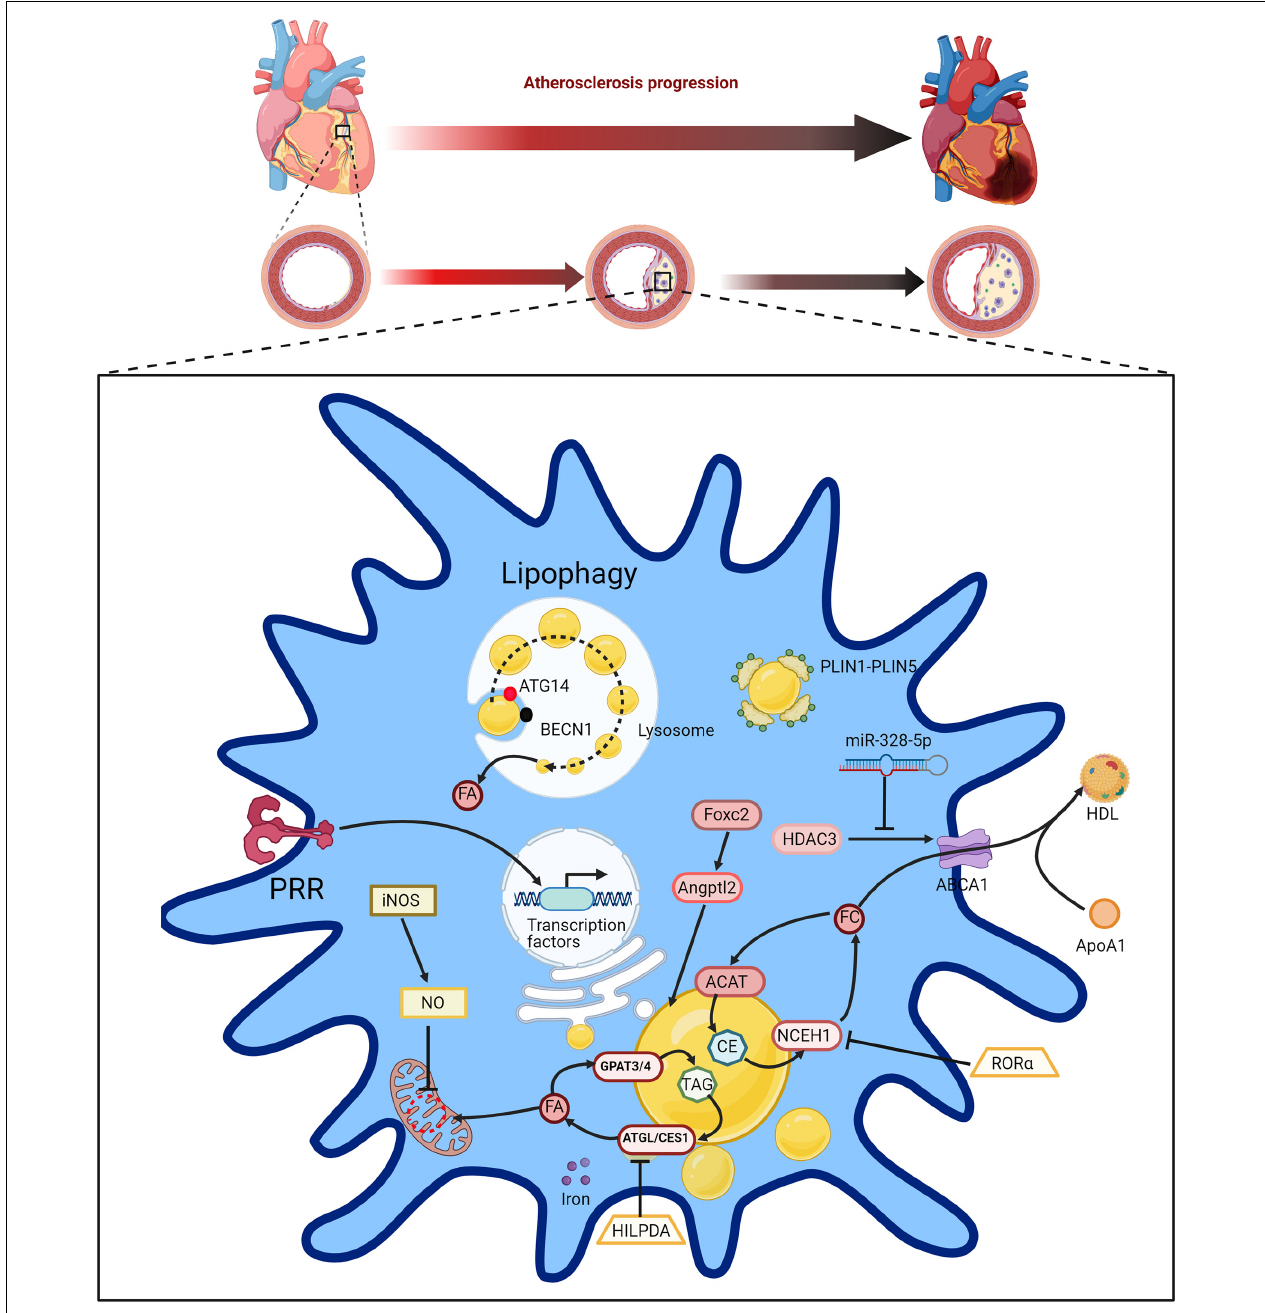
FIGURE 4 | Atherosclerosis is accompanied by the accumulation of LDs in macrophages. Macrophages can reduce excessive lipid accumulation in the body by increasing the lipopolysis of intracellular LDs and avoiding the damage of cells from lipid toxicity, thus alleviating the further development of atherosclerosis. Intracellular free cholesterol (FC) can be transferred extracellular by ABCA1 to combine with extracellular apolipoprotein A1 (ApoA1) to form high-density lipoprotein (HDL). The activity of ABCA1 is mediated by miR-328-5p reduction regulated histone deacetylase 3 (HDAC3). TAGs can be synthesized by FA under the action of GPAT3 and GPAT4, and TAGs break down to produce free fatty acids under the action of ATGL and CES1. The hydrolysis of cholesterol ester (CE) is catalyzed by neutral cholesterol ester hydrolase 1 (NCEH1) to produce free cholesterol (FE), and the synthesis of CE is catalyzed by acyl-coenzyme A-cholesterol acyltransferase (ACAT). Foxc2-induced Angptl2-mediated lipid accumulation is also associated with atherosclerosis. Nitric oxide (NO) derived from iNOS can inhibit mitochondrial respiration. The lipophagy can be mediated by BECN1 and ATG14 in macrophages, decomposing LDs to produce FA. The perilipin family of PLIN1-PLIN5 is the mark in LDs accumulation in macrophage. Hypoxia-inducible lipid droplet-associated protein (HILPDA) is a physiological inhibitor of ATGL-mediated lipopolysis in macrophages, binding to the intracellular triglyceride hydrolase ATGL and inhibiting ATGL-mediated triglyceride hydrolysis. Retinoic acid receptor-related orphan receptor α (ROR α ) can induce the high expression of NCEH1 in macrophages, thereby promoting the hydrolysis of cholesterol ester in LDs and alleviating lipid accumulation.